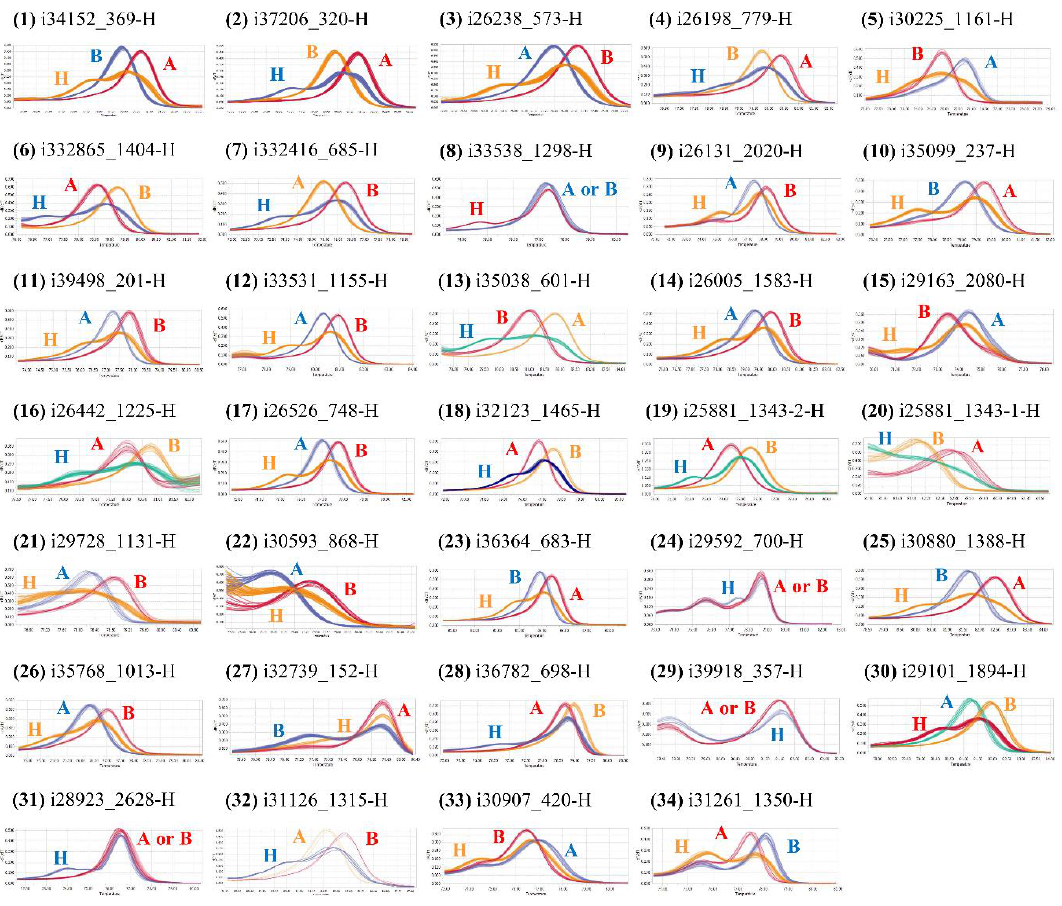
assembled contigs.